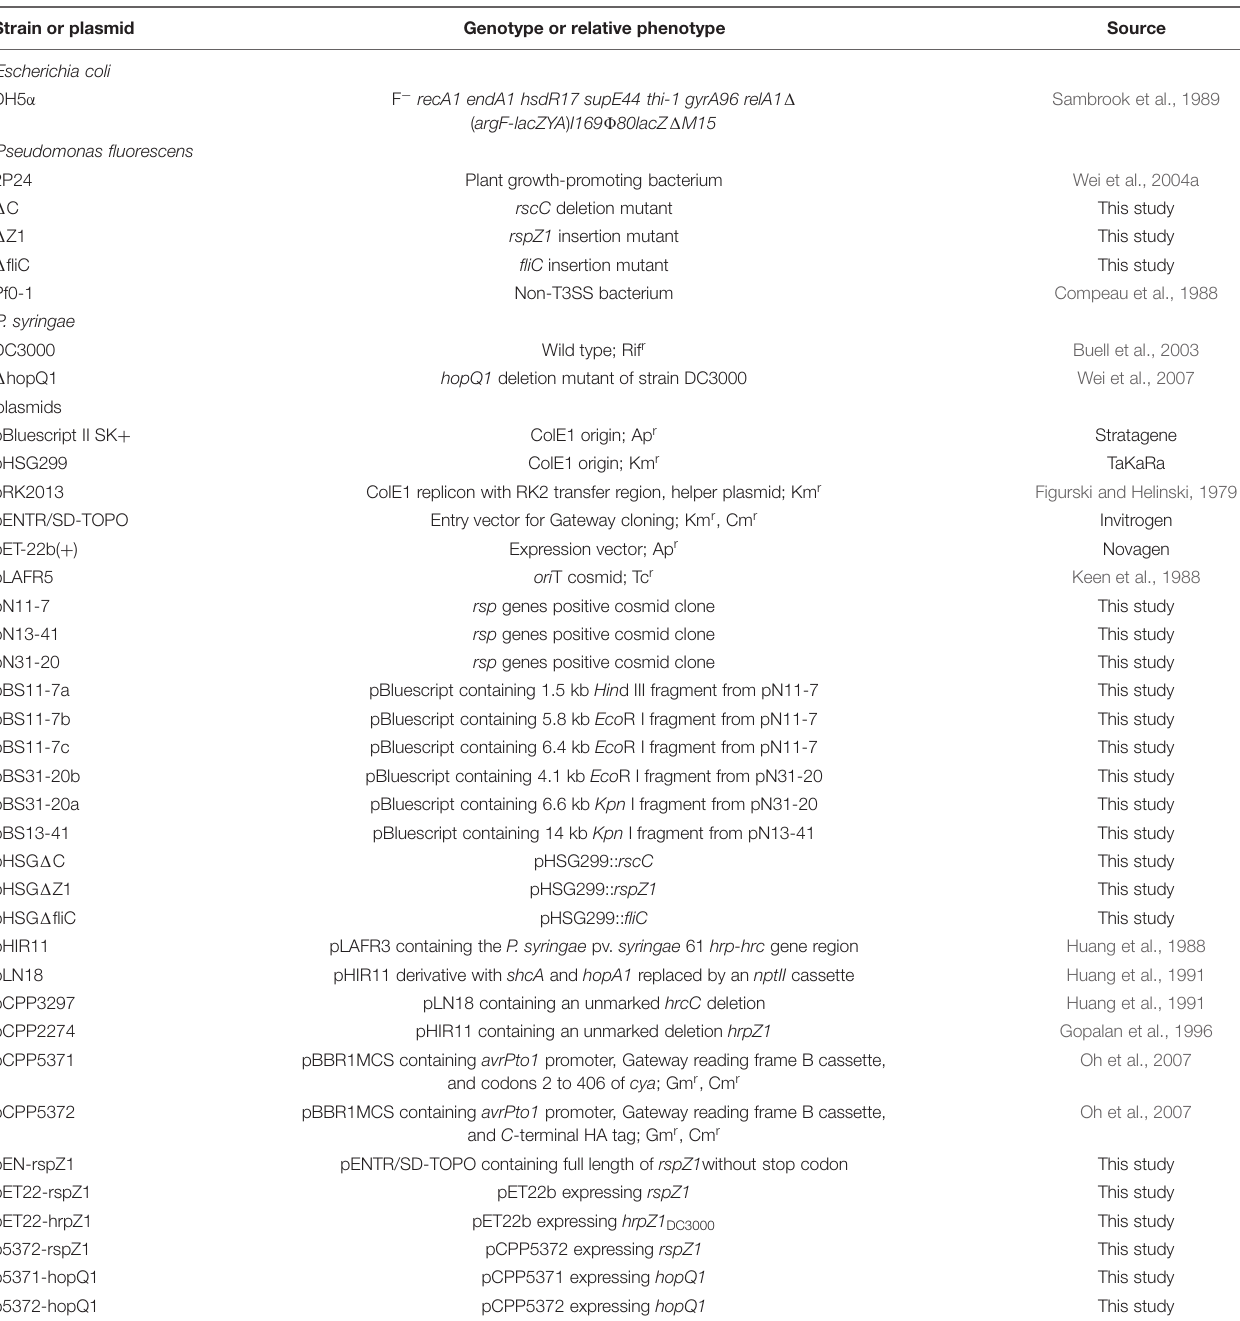
TABLE 1 | Bacterial strains and plasmids used in this